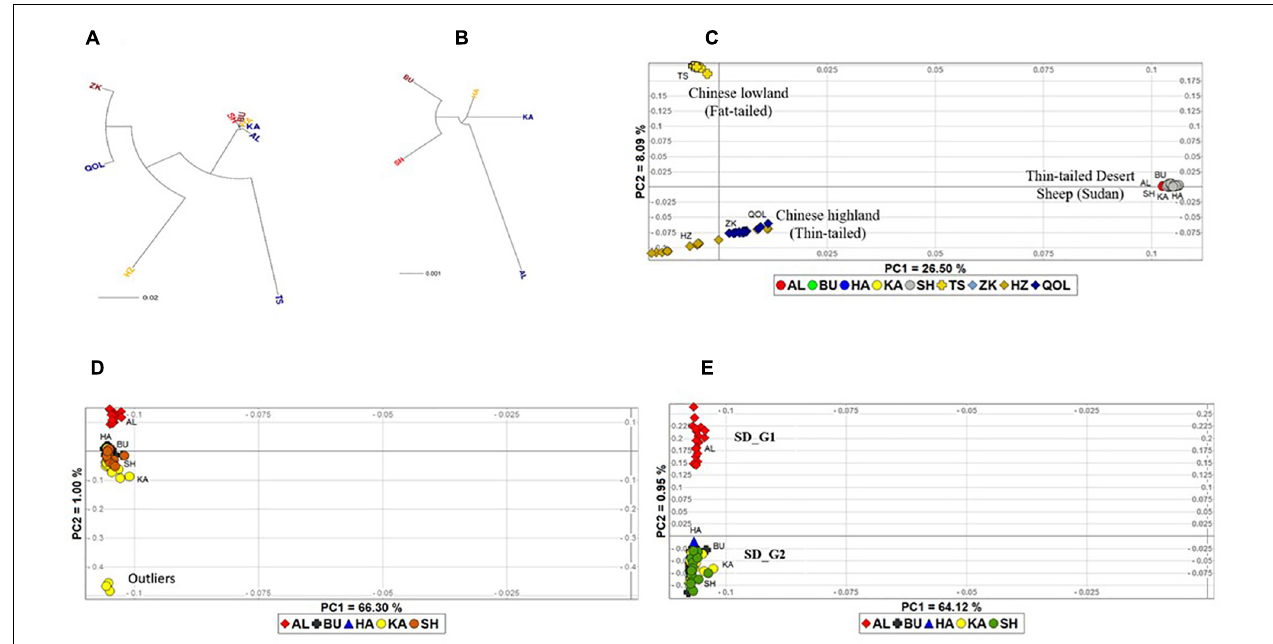
FIGURE 2 | Neighbor Joining tree of (A) all the five Sudanese thin-tailed Desert Sheep ecotypes and four breeds of Chinese sheep; (B) the five ecotypes of Sudanese thin-tailed Desert Sheep only; (C) PCA plot of all the individuals analyzed in this study; (D) PCA of Sudanese thin tailed Desert Sheep only; (E) PCA of the Sudanese thin-tailed Desert Sheep excluding the three outliers of the Kabashi